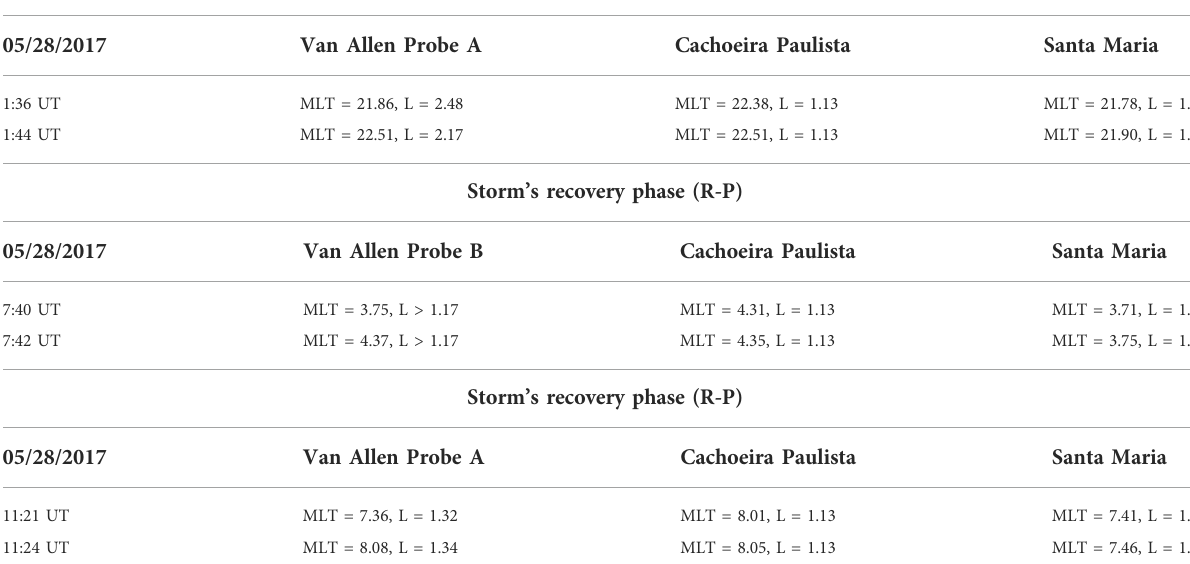
TABLE 1 The Magnetic Local Time (MLT) and L values of the VAP-A/B and the ionosonde stations during the conjunctions. The conjunctions were observed only during the storm ’ s main and recovery